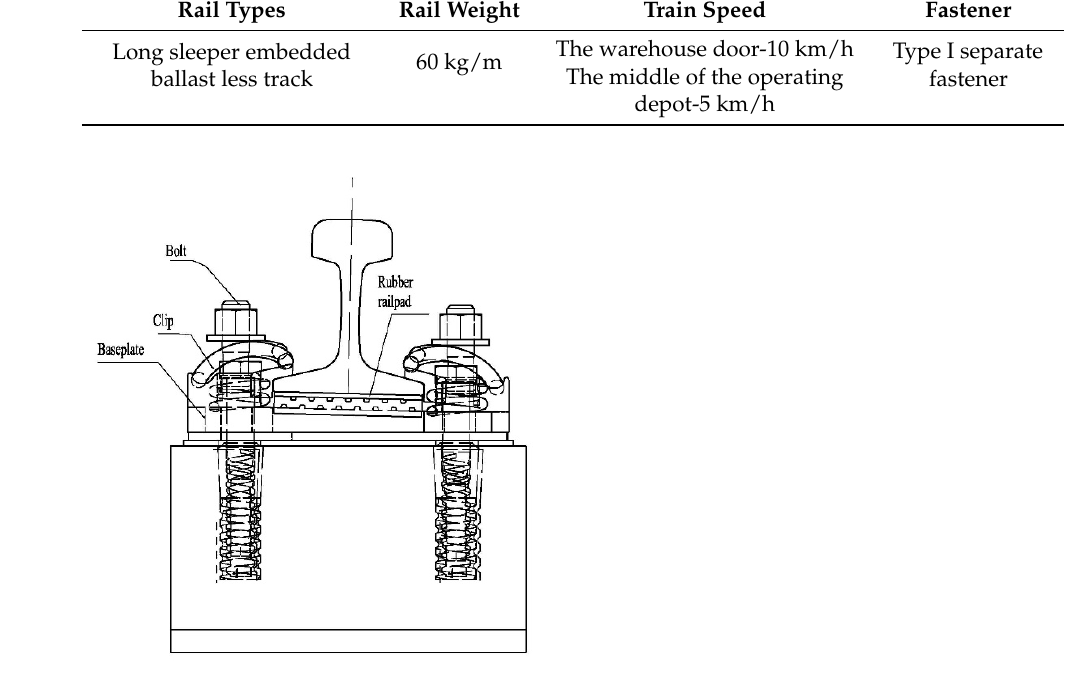
Figure 2. Type I separate fastener.